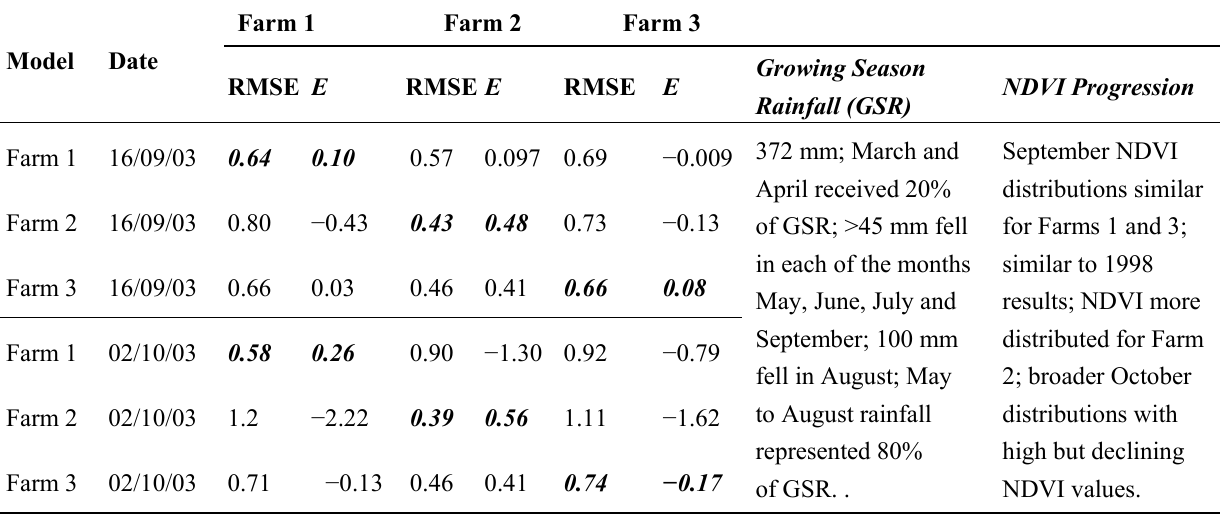
Table 7. Model and yield prediction efficiency criteria for 2003 Landsat imagery-Root Mean Square Error (RMSE) and the Nash-Sutcliffe Efficiency Criteria ( E ). Values in bold italics represent efficiency criteria for the calibration models. Descriptions of 2003 Growing season rainfall, NDVI progression and interpretations of